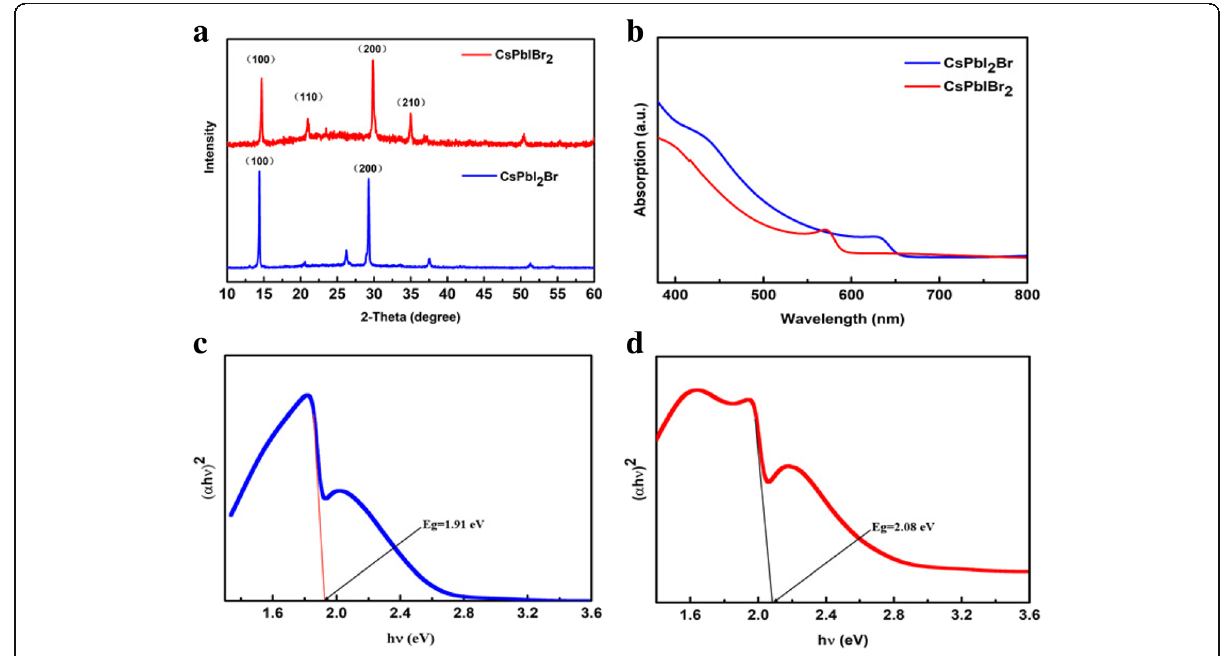
Fig. 2 a XRD patterns. b Absorption of the CsPbI 3-x Br x films. The band gap of c CsPbI 2 Br and d CsPbIBr